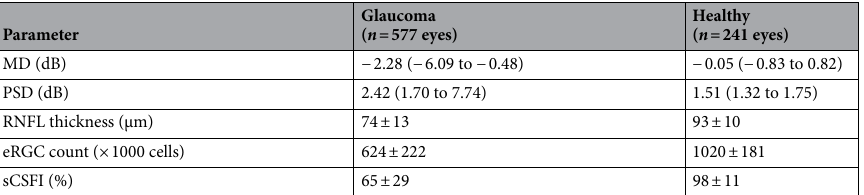
Table 1. Characteristics of the eyes included in this study at the first visit. Data are presented either as median (interquartile range) or the mean ± standard deviation; MD, mean deviation; PSD, pattern standard deviation; RNFL, retinal nerve fiber layer; eRGC Count, estimated retinal ganglion cell count; sCSFI, simplified combined structure–function index.